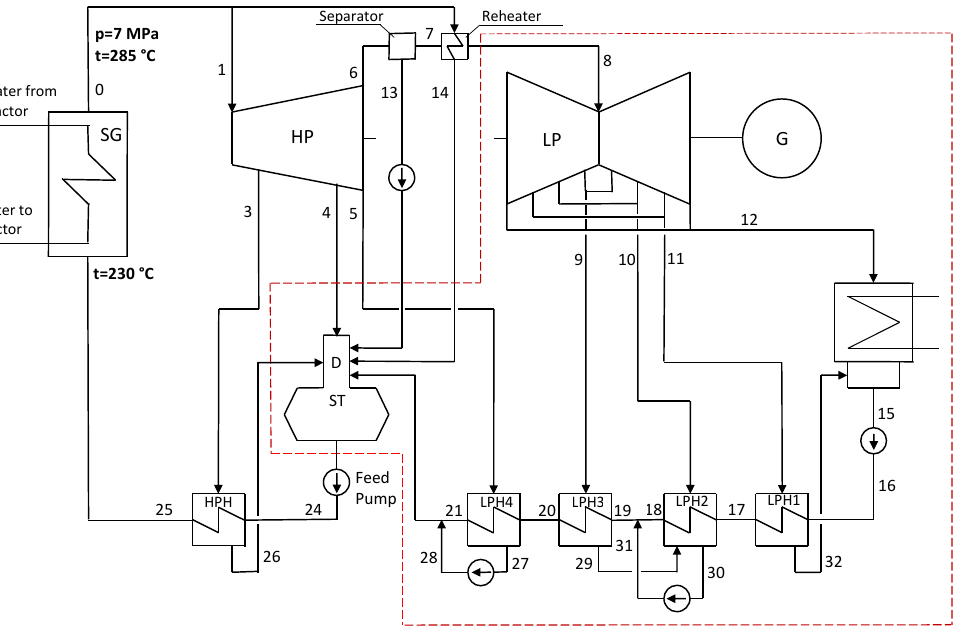
Figure 5. Diagram of the steam cycle with marked calculation points after modernization of the power unit (SG—steam generator, HP—the high-pressure section, LP—the low-pressure section, S—the moisture separator, R—the reheater, G—the generator, (LPH1–LPH4)—the low-pressure feed-water heaters, HPH—the high-pressure feed-water heater, D—the deaerator, ST—the feed-water storage tank). red dashed line—components previously used in the coal-fired power unit.